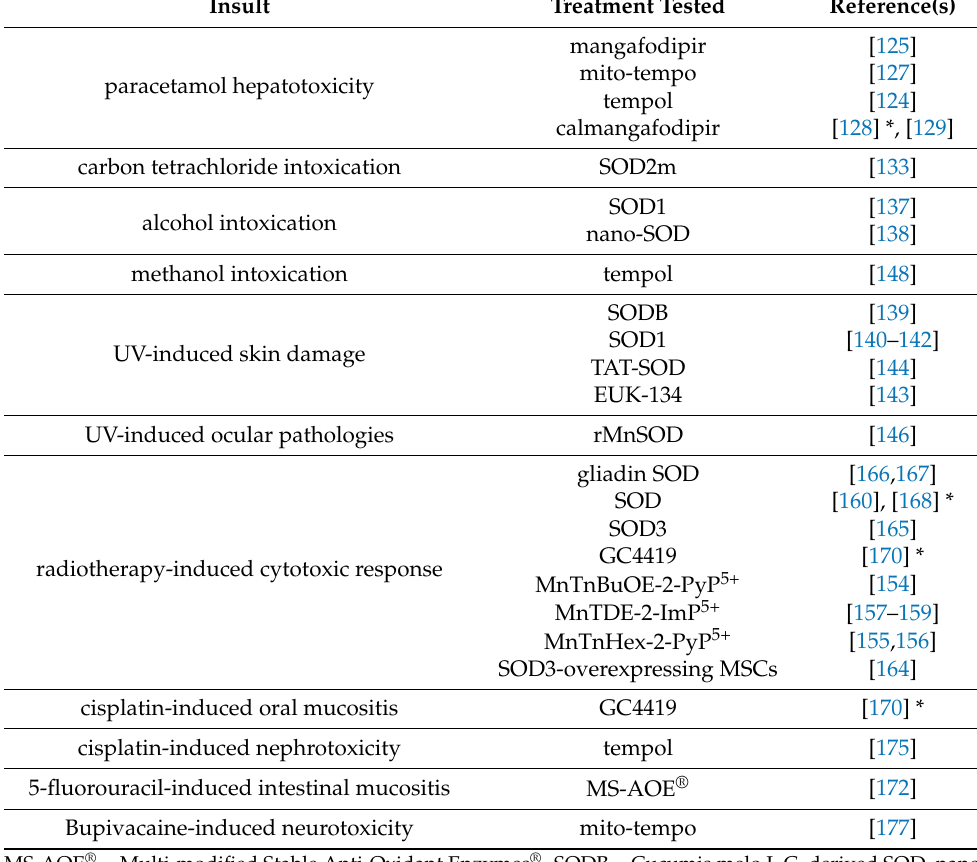
Table 1. Possible applications of SODs as a detoxification